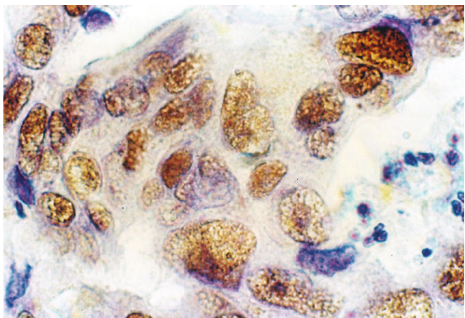
Figure 3: p53 immunoreactivity in infiltrating ductal carcinoma of the breast (invasive margins). Anti-p53 cell staining showing variation in the distribution and intensity of staining. In contrast to the darker, more sharply defined nuclear staining, a diffuse pattern of staining was identified in the cytoplasm of tumor cells. Larger and more irregular tumor cell nuclei had deeply invaginated sur- faces (frozen section, immunoperoxidase with mAb DO-7, nuclear counterstain with haematoxylin, ×